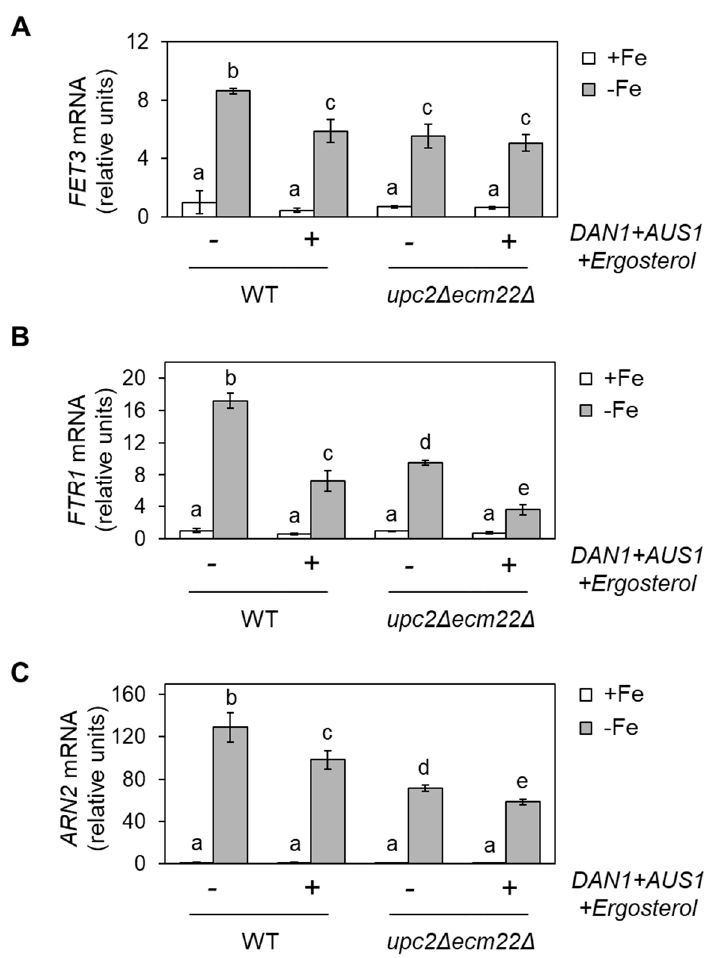
Figure 3. Supplementation with ergosterol decreases the iron regulon activation upon iron deficiency. Wild-type (WT, W303) and upc2 ∆ ecm22 ∆ cells were transformed with both pNEV- DAN1 and YEp13- AUS1 plasmids or with the two corresponding empty vectors, pNEV, and YEp13. Then, transformed cells were cultivated at 30 ◦ C for 6 h in SC-Ura-Leu medium without (+Fe) or with 100 µ M BPS ( − Fe). Then, 80 µ g/mL ergosterol was added to cells expressing DAN1 and AUS1. Total RNA was extracted, and FET3 ( A ), FTR1 ( B ), and ARN2 ( C ) mRNA levels normalized with ACT1 mRNA were determined by RT-qPCR. Data show the average and SD of three independent experiments relative to wild-type cells grown in +Fe conditions. Significant differences are indicated above bars ( p -value <